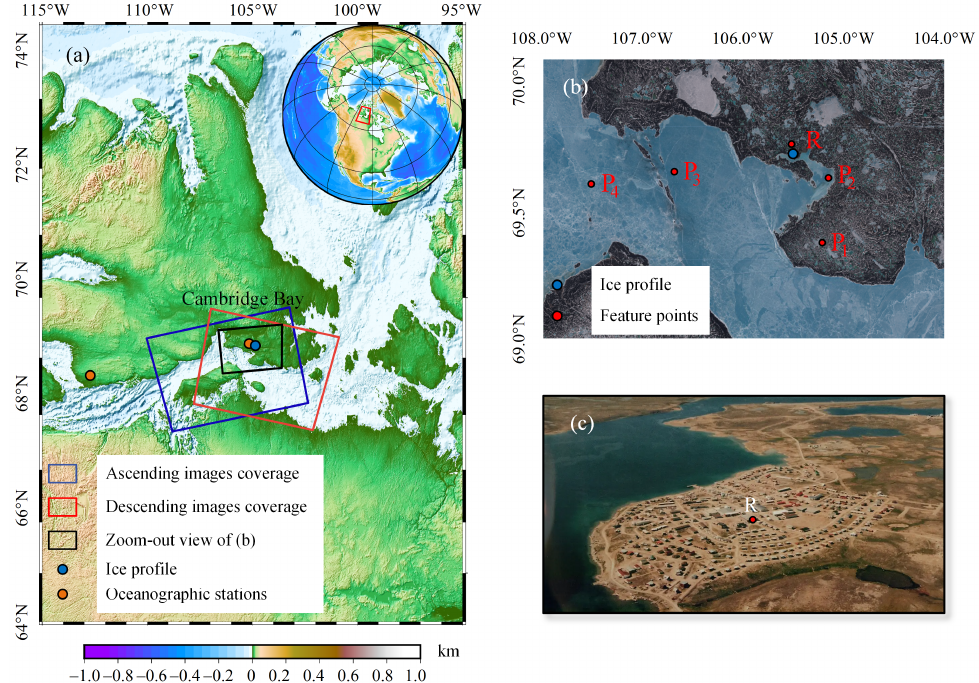
Figure 3. Study area: ( a ) Location of Cambridge Bay, with the blue and red rectangles representing, respectively, the coverage of ascending and descending images; the black rectangle defines the zoomed-out view of ( b ); the yellow circles and blue circle represent the oceanographic stations and ice profile. ( b ) Specific location of feature and reference points of phase unwrapping, with the Sentinel-2 images being the base map. ( c ) Site picture of Cambridge Bay where reference point R is